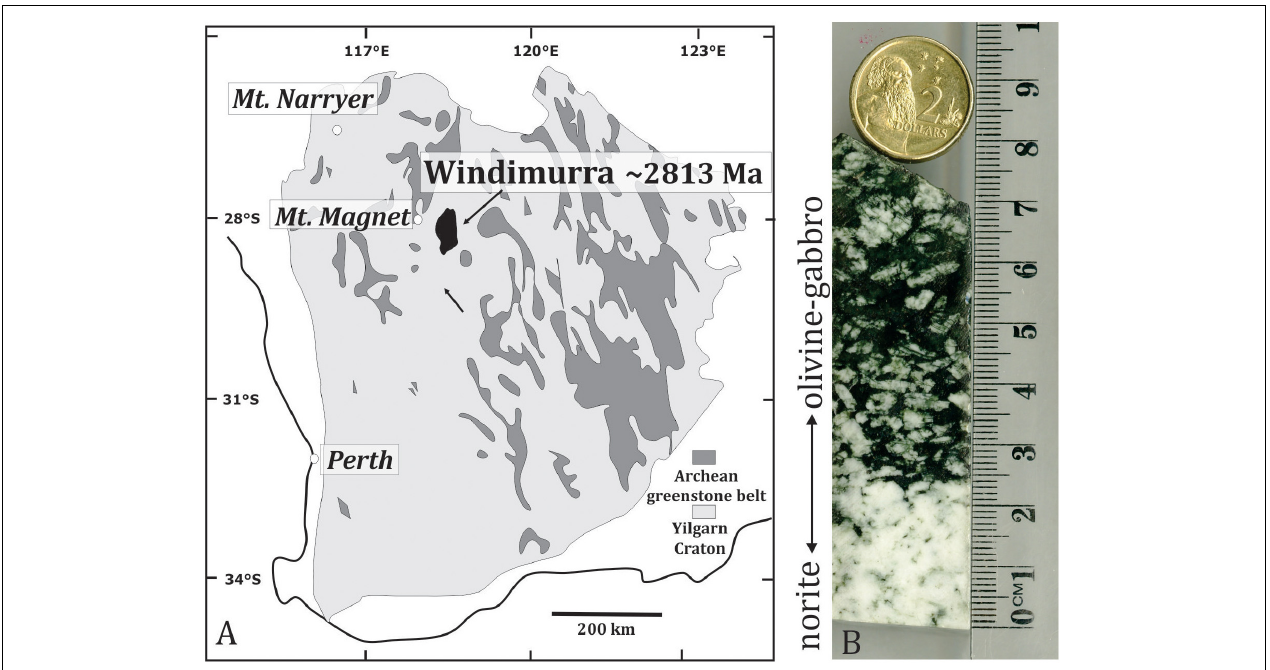
FIGURE 1 | (A) Location map of the Windimurra intrusion (modified after Nebel et al., 2013a) relative to the greater Yilgarn Craton. (B) Photograph of a typical drill core sample with the classical cumulate layers showing an olivine and pyroxene dominated layer at the top and a feldspar dominated layer at the bottom.